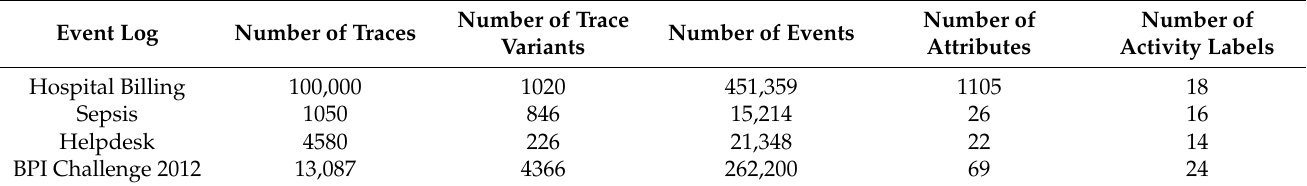
Table 1. Characteristics of event logs used for